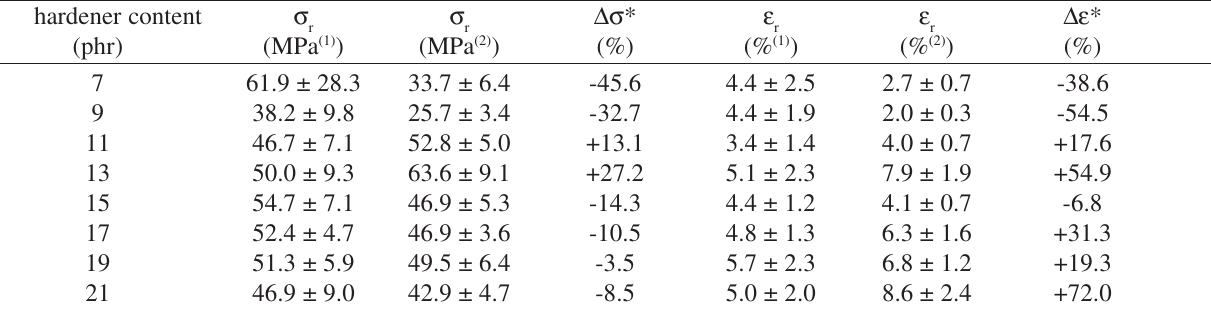
Table 1. Tensile properties of the DGEBA/TETA epoxy formulations.